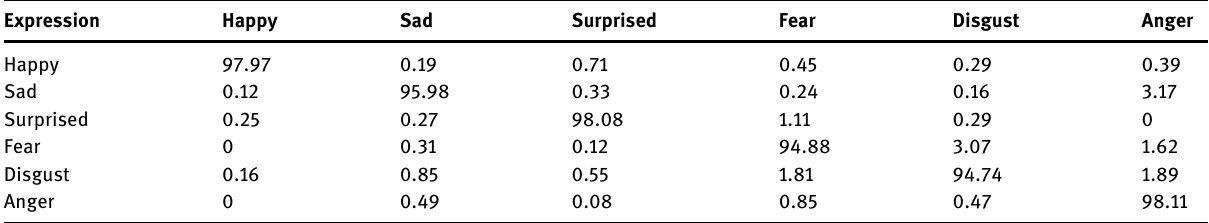
Table 3: Confusion matrix of the CK + dataset